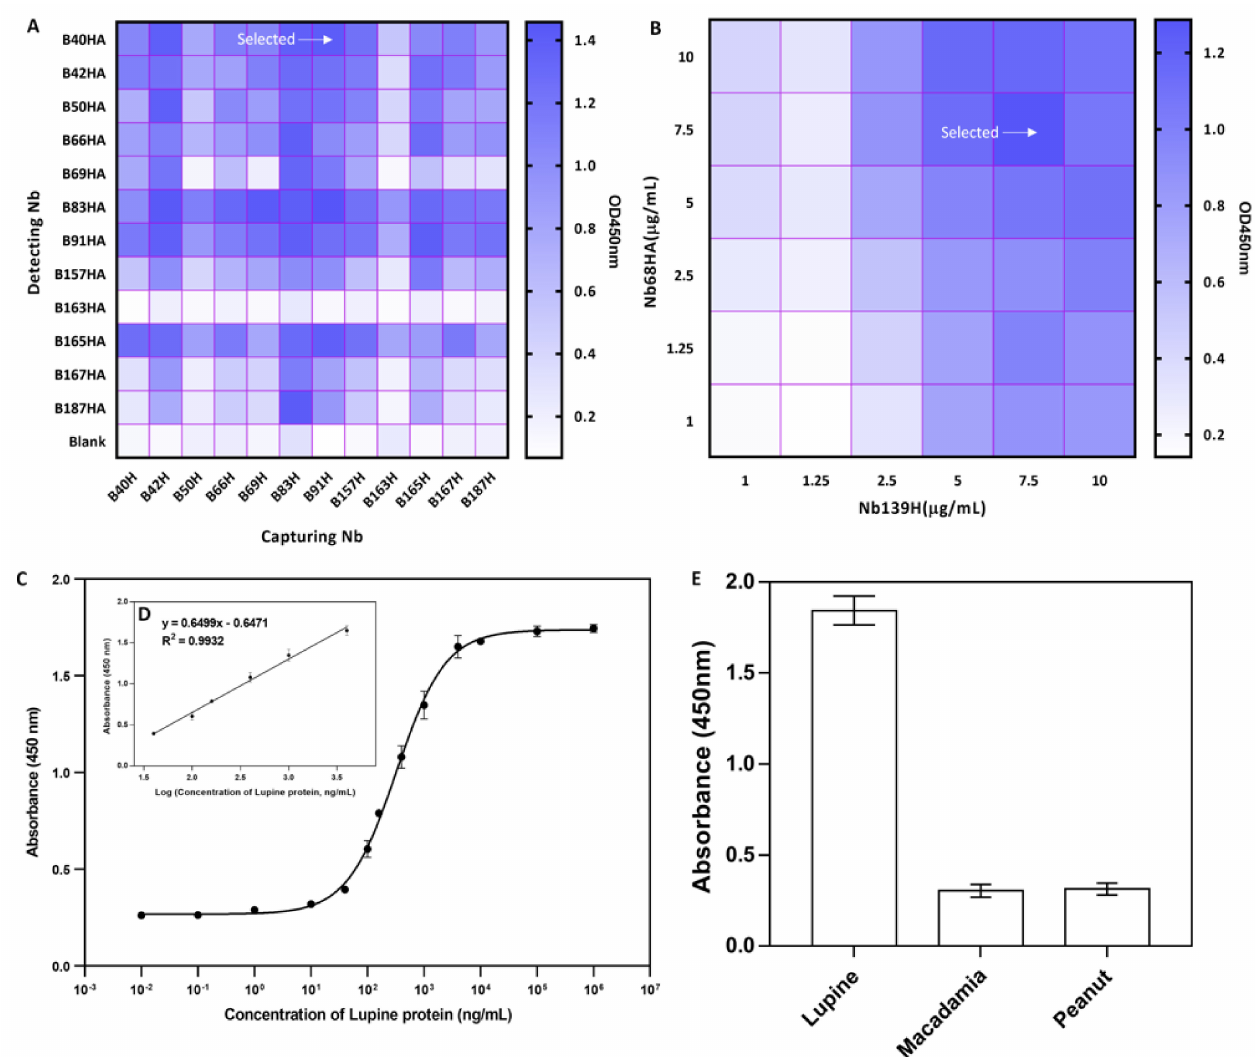
Figure 6. Development of a heterologous sandwich ELISA for detection of Lup an 1 allergen. ( A ). Selection of Nb-pair with best performance including a high response and low background. Nb B91H was selected as the capturing antibody, and Nb B40HA was selected as the detecting antibody. ( B ). The concentration of capturing and detecting Nbs was optimized based on the response and background. The concentration of 7.5 µ g/mL was selected for both the capturing and detecting antibodies. ( C ). Calibration curve of the developed sandwich ELISA for detection of lupine allergen. ( D ). Linear standard curve of the established immunoassay. ( E ). Specificity and cross-reactivity of the developed sandwich ELISA. Data are indicated as mean ± SD ( n = 3) with